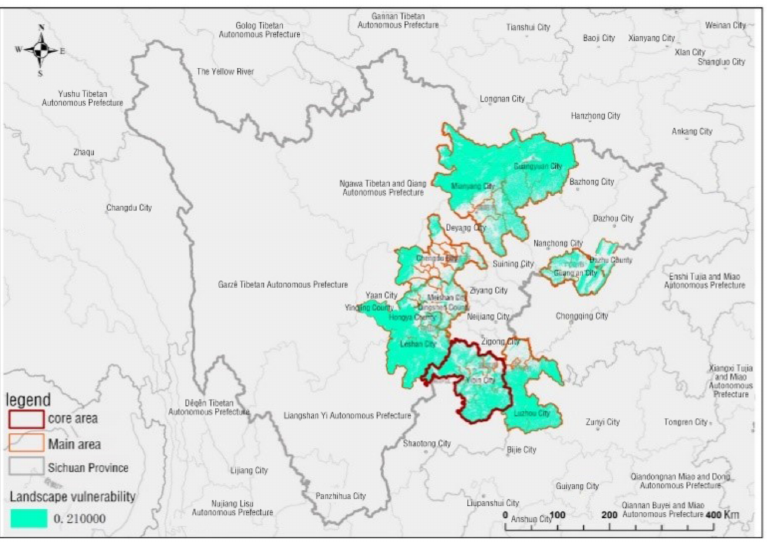
Figure 21. Landscape pattern index (landscape vulnerability) of research areas in Sichuan